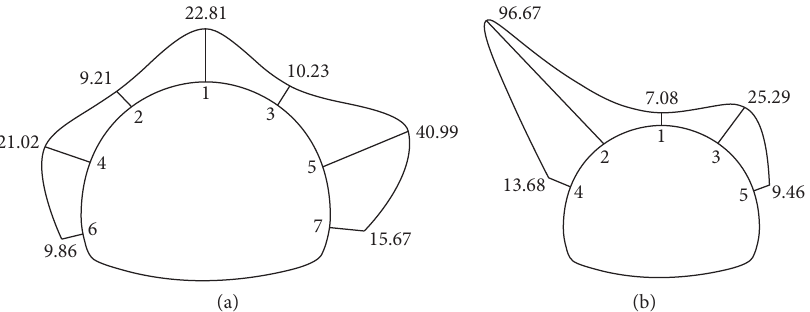
Figure 18: Contact pressure distribution between surrounding rock and initial branch (unit: kPa). (a) Pressure distribution of section 150. (b) Pressure distribution of section 920.